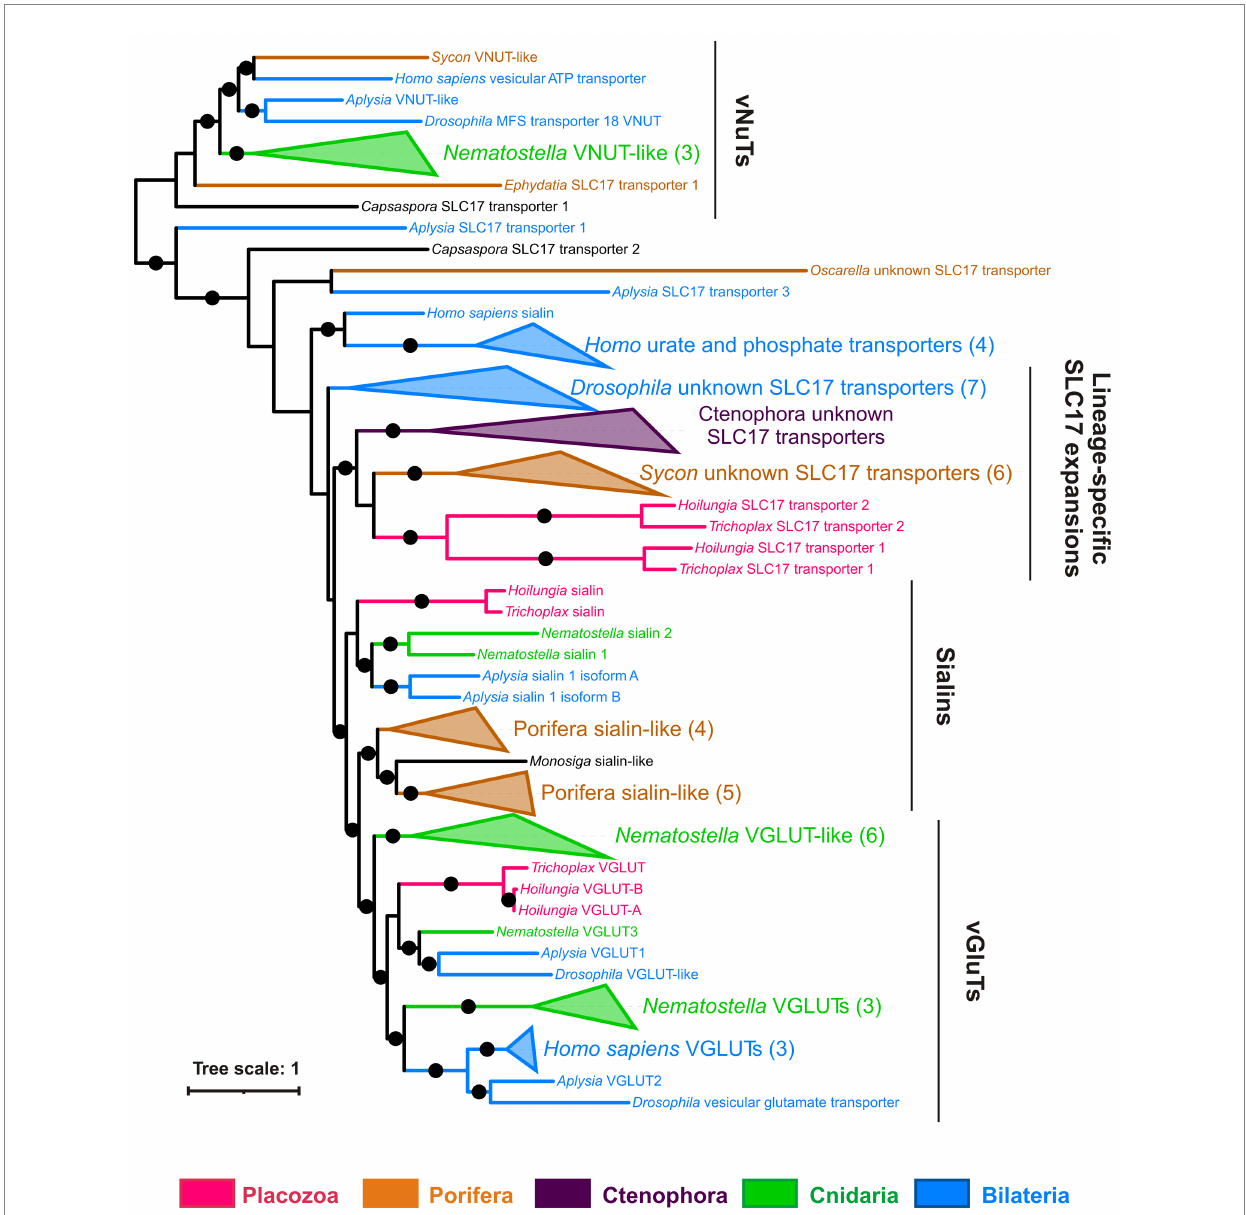
FIGURE 13 Trichoplax has a gene encoded putative vesicular glutamate transporter but no vesicular ATP transporters. Bayesian tree of vesicular glutamate and related transporters (SLC17 family) is shown. The superfamily of SLC17 transporters includes transmembrane carriers for various anions (phosphate, nucleotides, glutamate, and sialic acid). There are three well-defined clades of vesicular glutamate (vGluTs), sialins, and vesicular nucleotide (vNuT) transporters, plus several independent branches with lineage-specific expansions. Placozoan ( Trichoplax and Hoilungia ) transporters fall within vGluT and sialin clades, plus one separate clade of unknown substrate specificity. Full uncollapsed trees with numeric support values can be found in Supplementary Figure